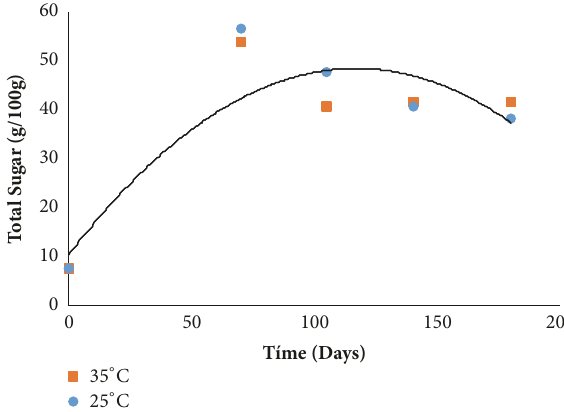
Figure 3: Total sugar behavior during